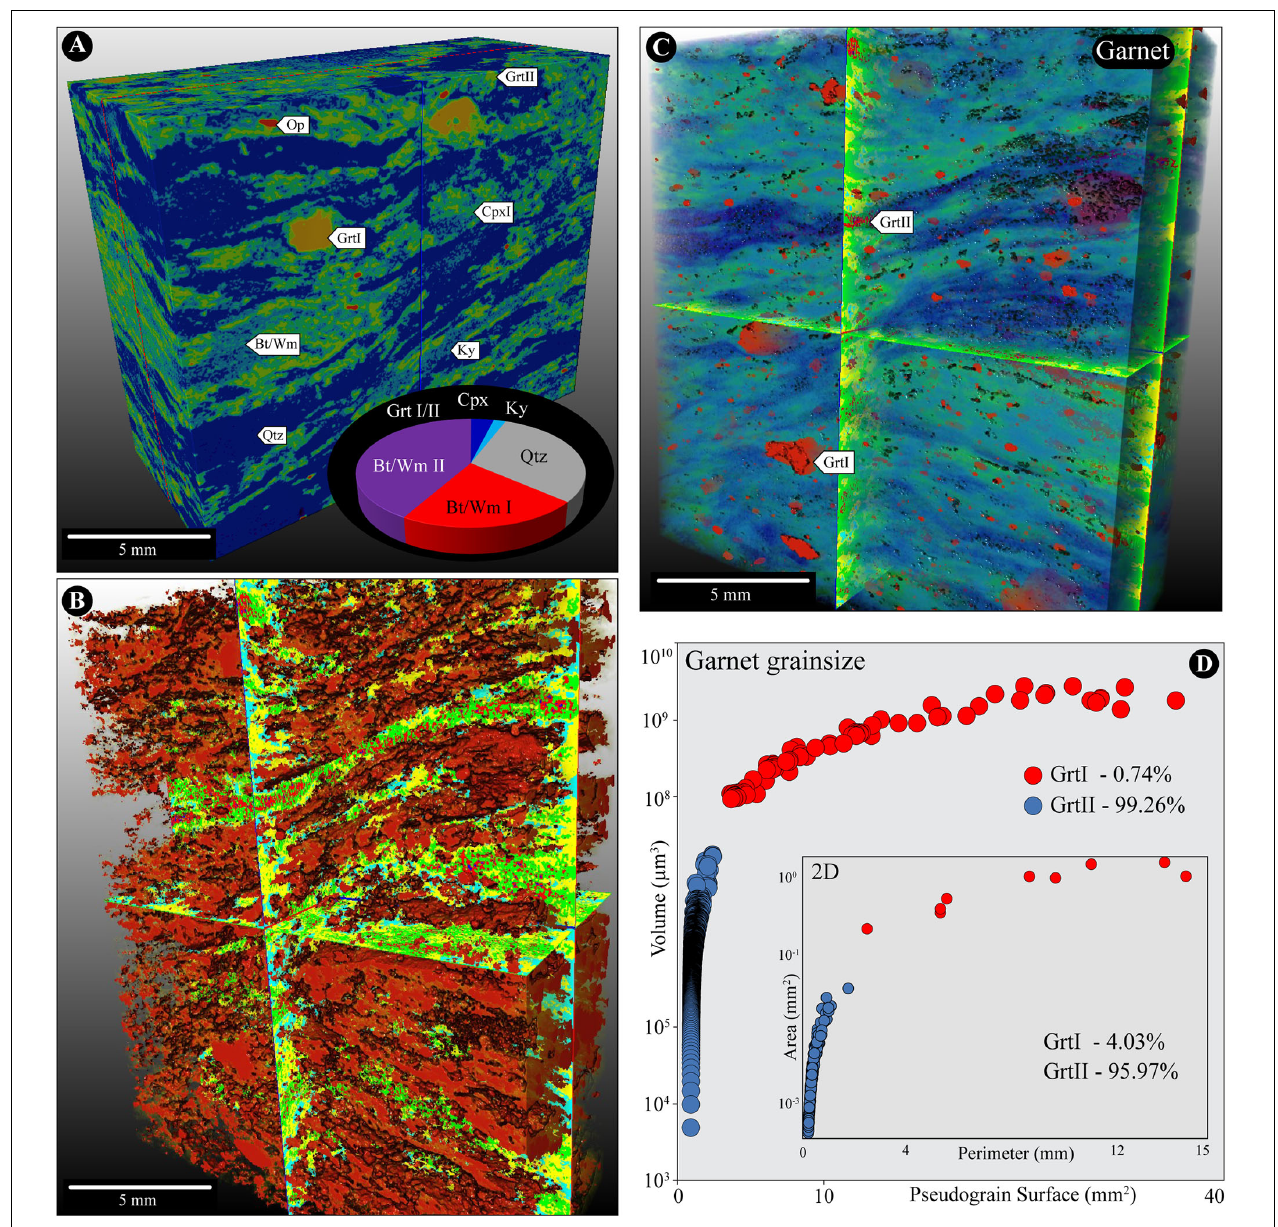
FIGURE 11 | (A) Volume rendering of the segmented phases and the volumetric quantification of each phase. (B) Example of mineral segmentation (e.g., Qtz) showing the preservation of pre-S1 fabric. (C) Garnet pseudo-grains are highlighted within the entire rock-volume. (D) Grainsize vs. surface of Grt pseudo-grains.